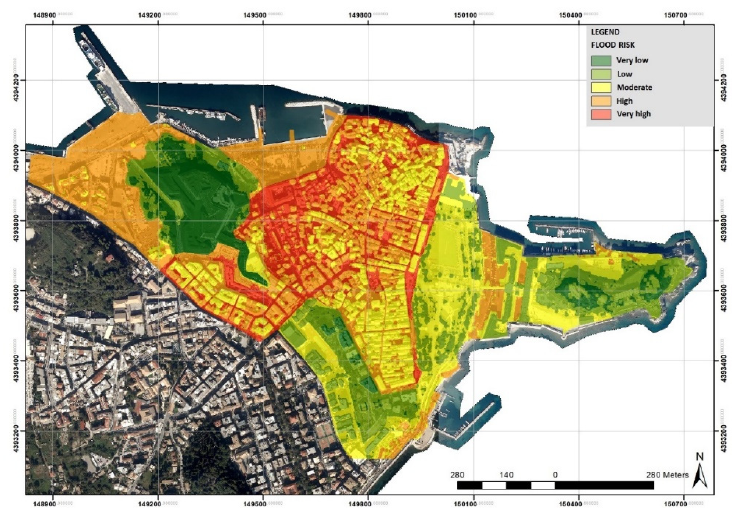
Figure 17. Flood hazard map for the maximum rain rate of the climate scenario (2031–2060, RCP 8.5) .